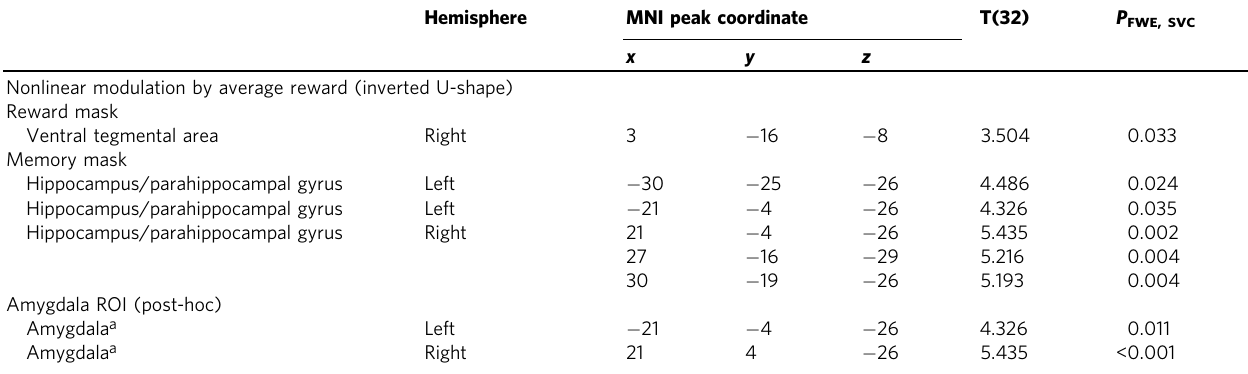
p FWE, SVC indicates the p value resulting from family-wise error (FWE) small volume correction (SVC) on peak voxel activity within a priori ROIs and the amygdala ROI. T-statistics were obtained from t - tests. ns , not signi fi cant. a The amygdala was not part of the initial hypotheses, thus a stricter (Bonferroni-corrected) statistical threshold was applied in order to infer any involvement of the amygdala ( α =